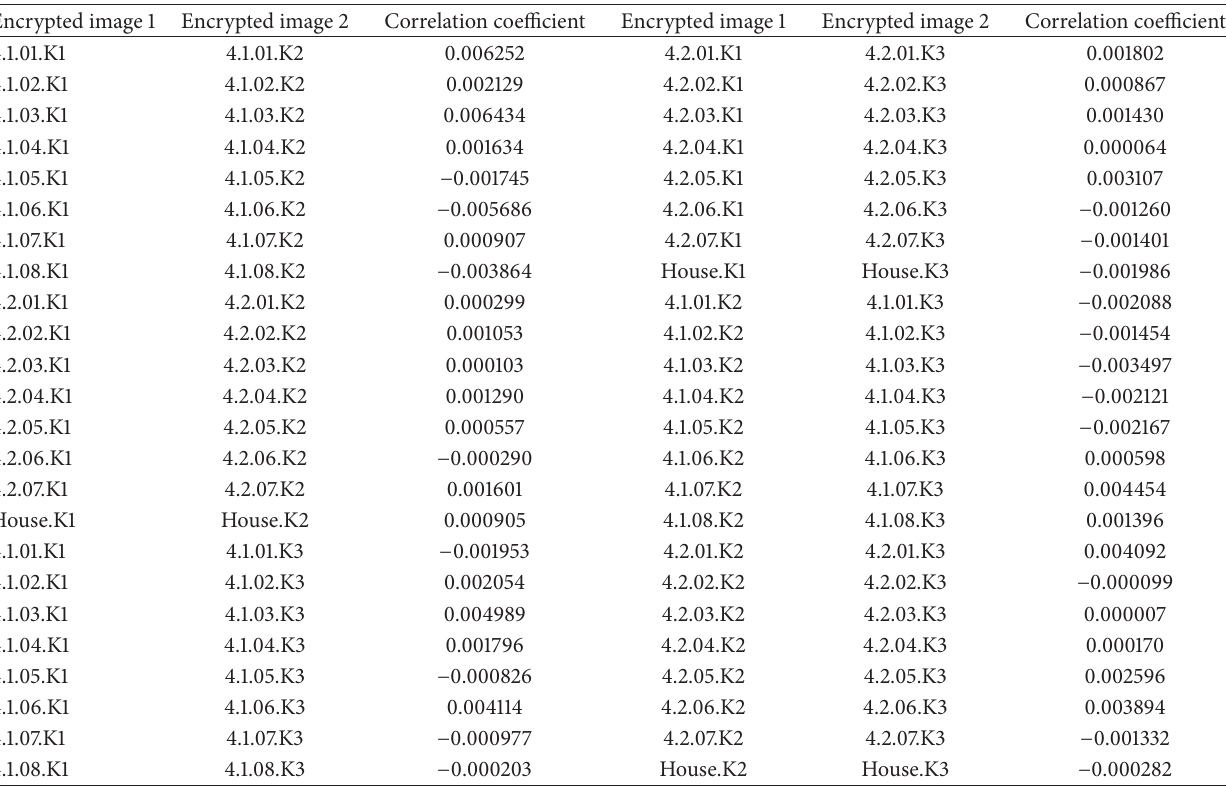
Table 8: Correlation coefficients between the corresponding pixels of the 48 different encrypted images obtained from the 16 plain images by using the three slightly different secret keys: K1, K2, and K3.